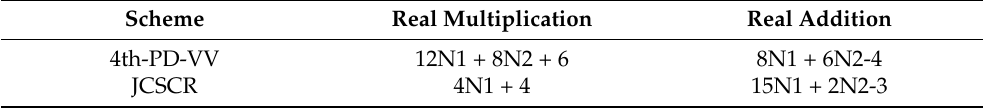
Table 1. Computational complexity of different schemes. Scheme Real Multiplication Real